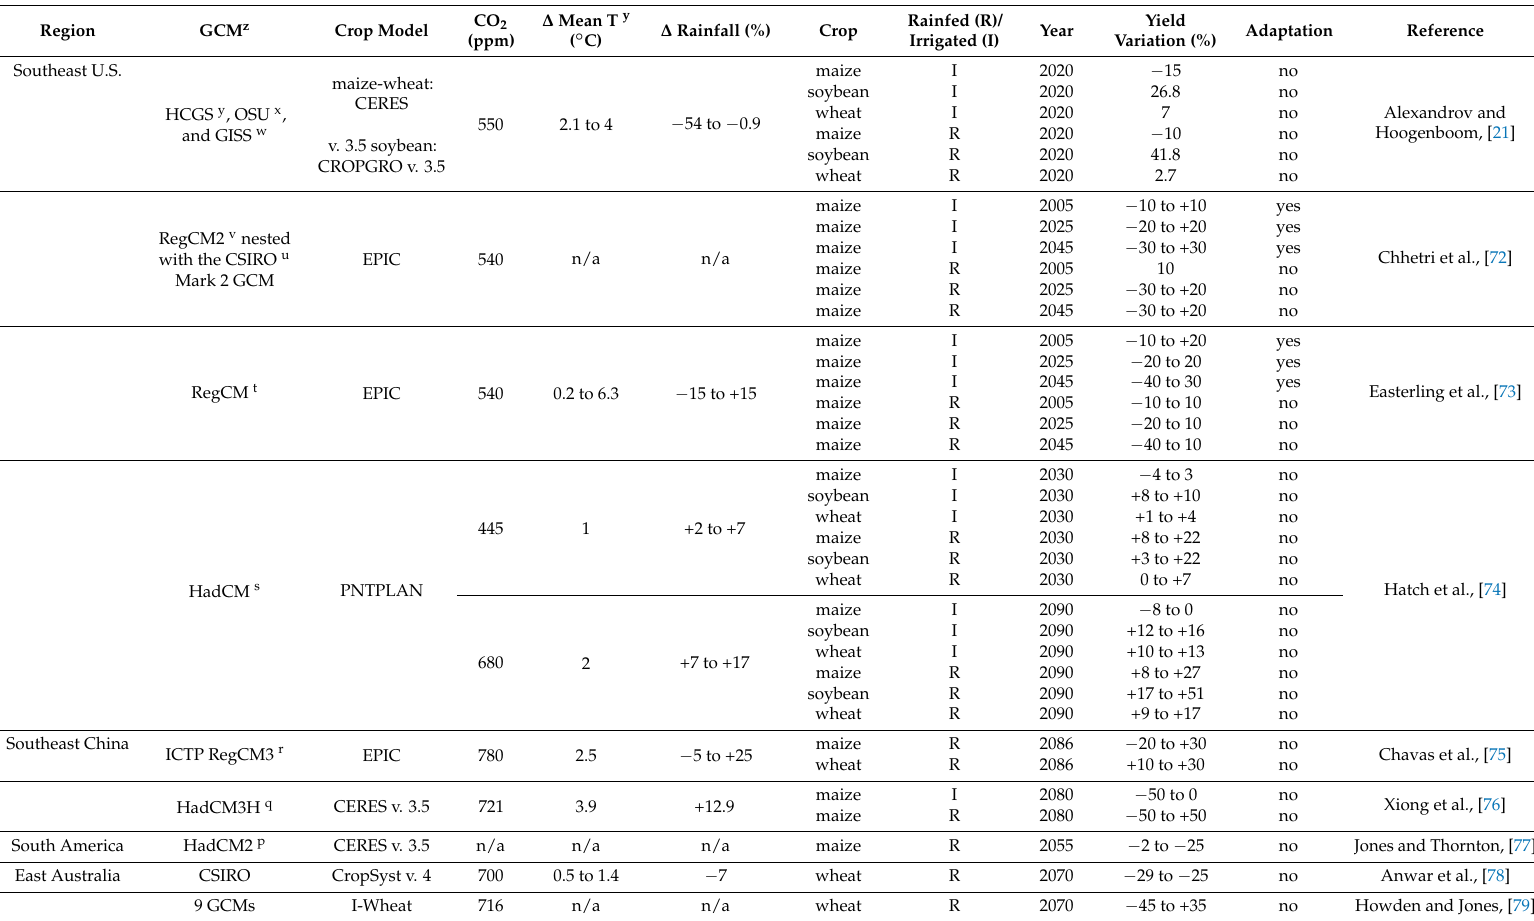
Table 3. Climate change impact studies for wheat, soybean, and maize in the humid subtropical regions of southeast U.S., southeast China, South America, and east Australia.